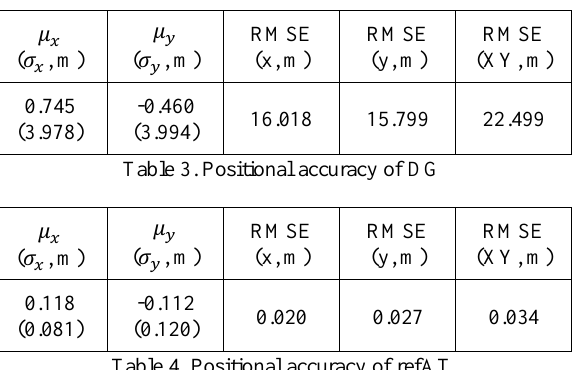
Table 4. Positional accuracy of refAT